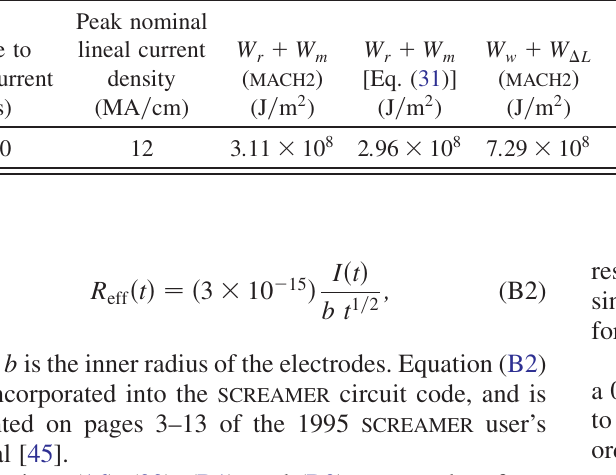
ENERGY LOSS TO CONDUCTORS . . TABLE III. Summary of conductor-energy-loss calculations performed to quantify the accuracy of the 1D-planar approximation. These assume a linear-ramp current pulse is applied to a 0.3-cm-radius solid cylinder of stainless steel. The numerical results are obtained from a 1D Lagrangian MHD simulation performed using the MACH2 code [28,30,31]. The losses presented here are those given by Eq. (33) agrees to first order with the simulation result. obtained at peak current. As suggested below, the total energy loss W t Time to